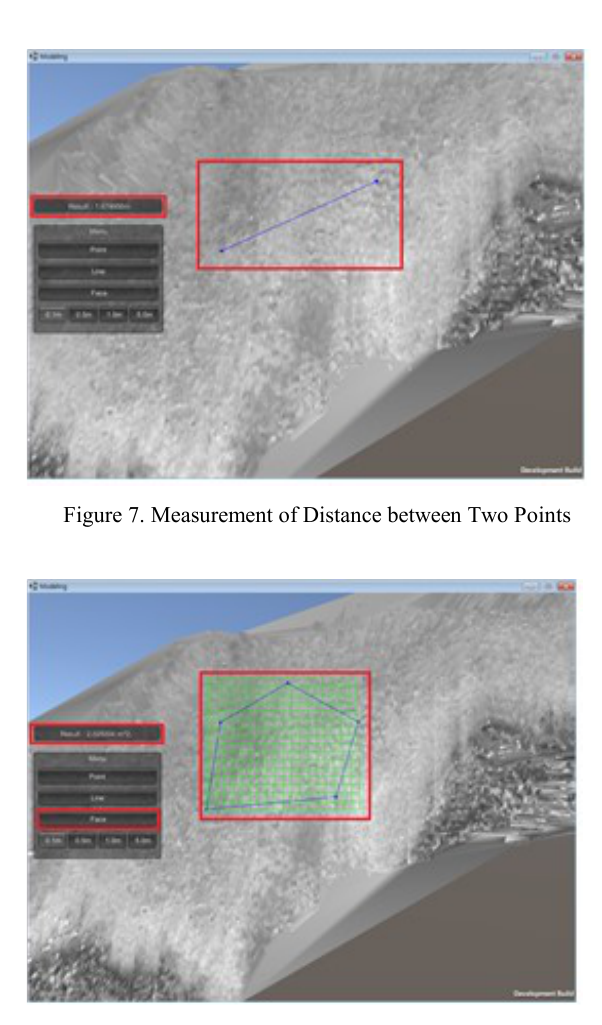
Figure 6. Visualize 3D Point Coordination